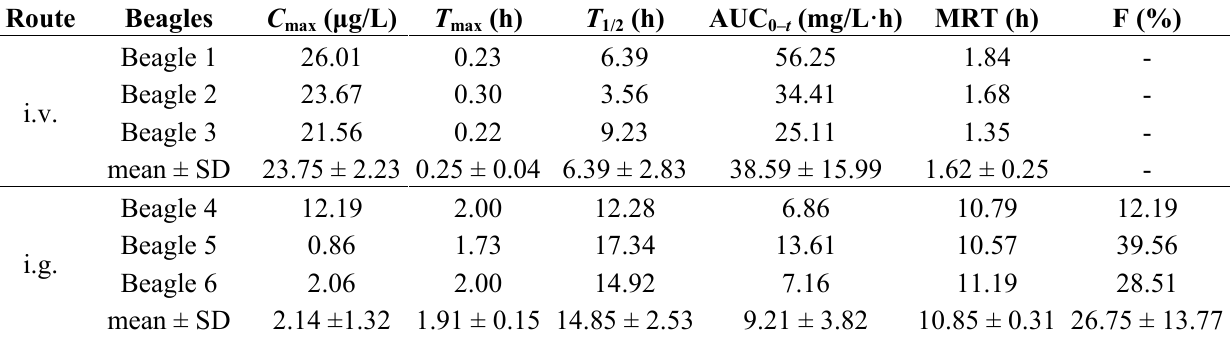
Table 6. Pharmacokinetic parameters of NCE in beagle dogs. C concentration; T , time of peak; AUC , area under the plasma concentration-time curve max 0 –t from 0– t h; MRT, mean residence time; F, absolute